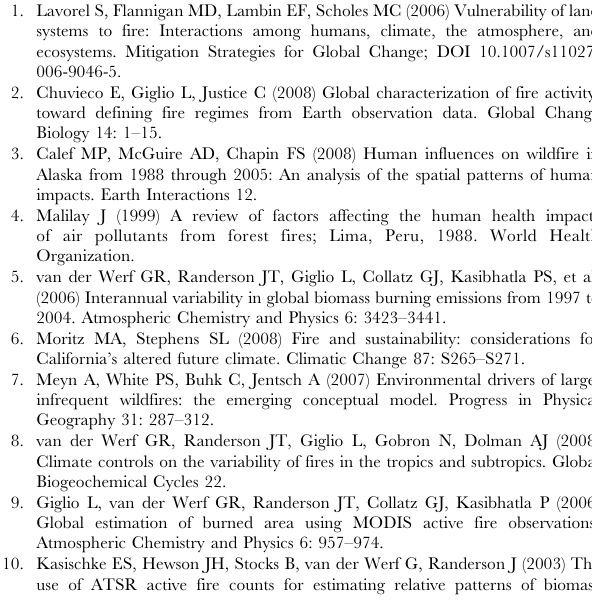
Figure S9 Comparison of mean temperature of the wettest month from 15 AOGCMs. Periods of comparison include: 2010– 2039 (A), 2040–2069 (B) and 2070–2099 (C) under the SRES A2 (mid-high) emissions scenario. The GFDL CM2.1 projections (outlined) are relatively conservative - by the end of the